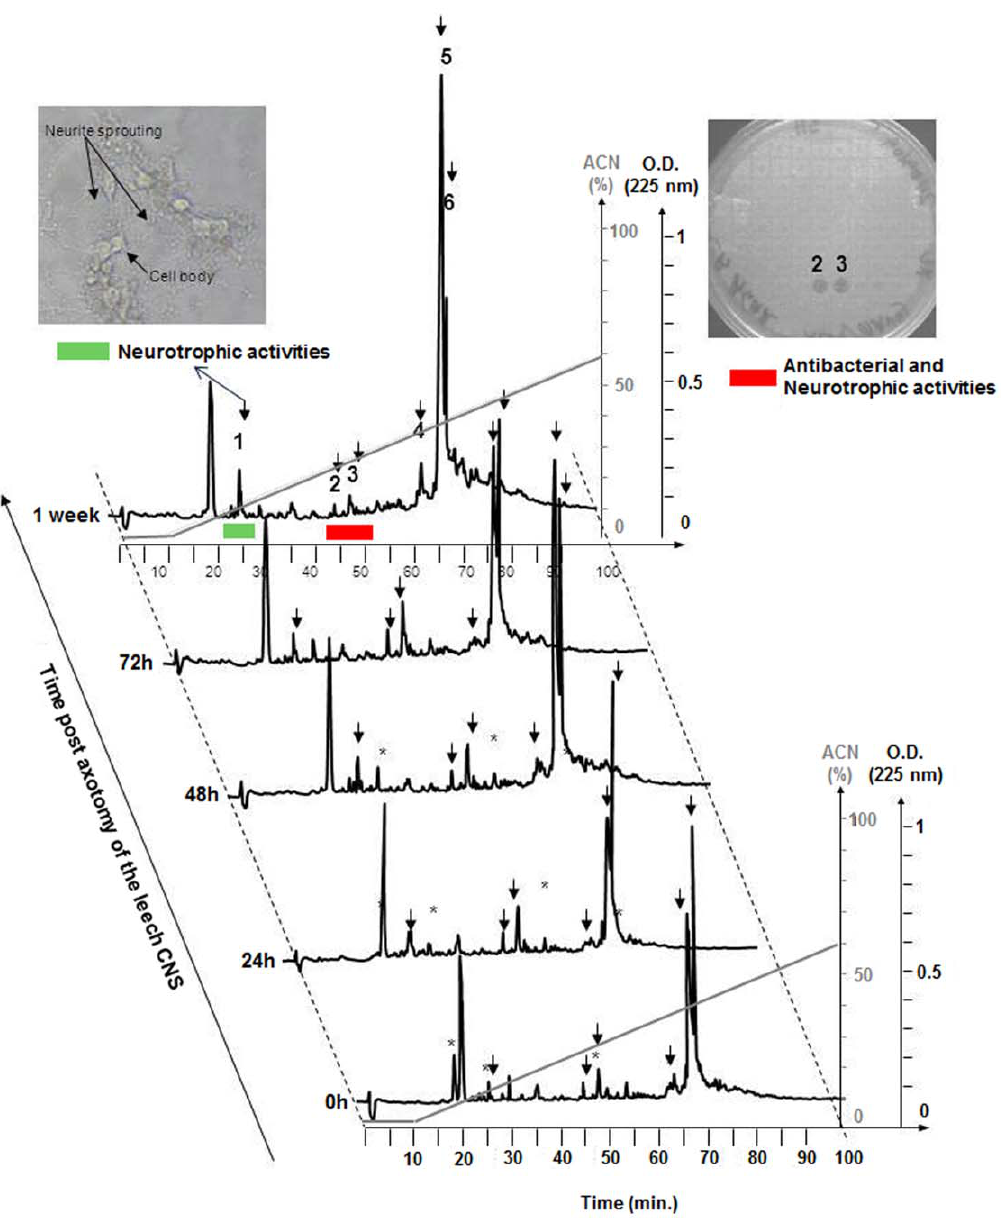
Figure 4. DD-RP-HPLC of leech axotomized nerve cords acidic extracts at different times after connective nerve trans-section. After prepurification by solid phase extraction, the 60% AcN eluted material is loaded onto a C18 column. Elution is performed with a linear gradient of AcN (dotted line) and absorbance was monitored at 225 nm. Each individually collected peak is tested for its neurites outgrowth (example in upper left insert) and antimicrobial (example upper right insert) activities. The peaks that showed temporal variation in intensity, whether they produced antimicrobial or neurotrophic activity or not, are further purified and the peptides are identified by MALDI-TOF mass spectrometry and Edman degradation. Sequence results and peptide identification are shown in Table